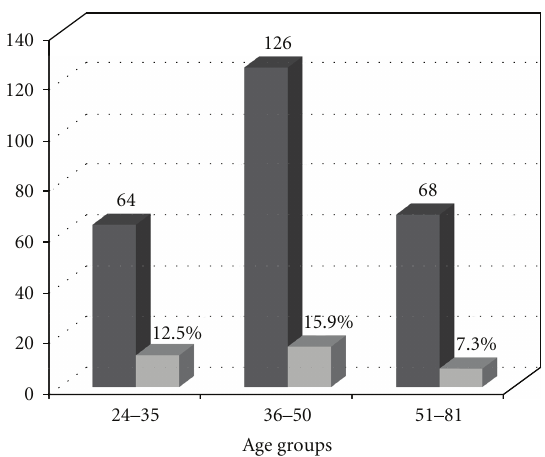
Figure 5: Seroprevalence of Chagas disease distributed by age groups compared with the total of sera. For range from 24 to 35, n = 64, range from 36 to 50, n = 126, and range from 51 to 81, n = 68.